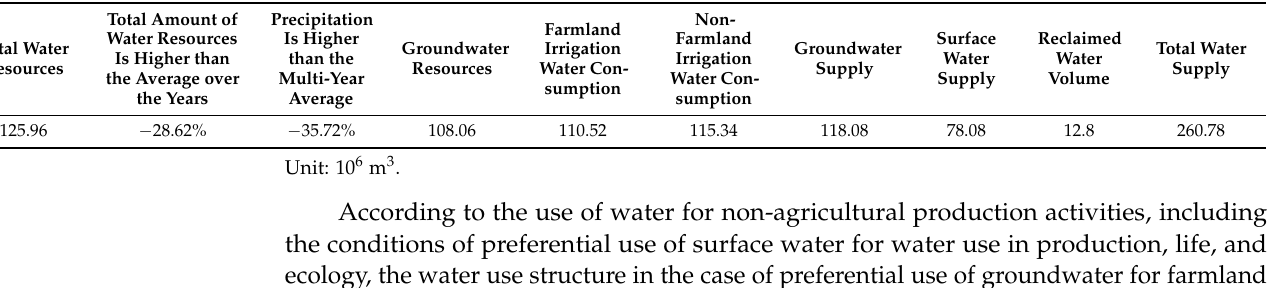
Table 4. The amount of water resources and their utilization for Lancang County in 2021.